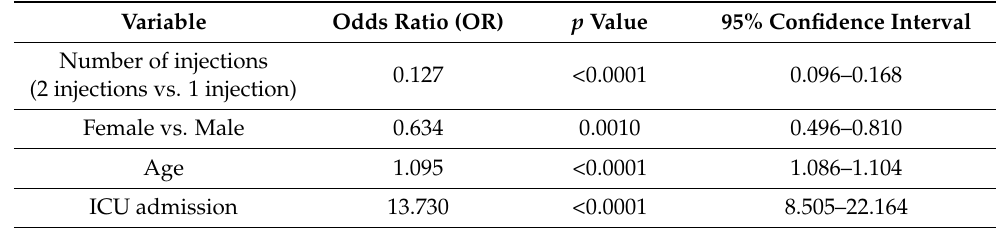
Table 4. Multiple logistic regression for the association between the number of vaccine injections and mortality among vaccinated COVID-19 patients with Pfizer–BioNTech vaccine (n = 86,849).